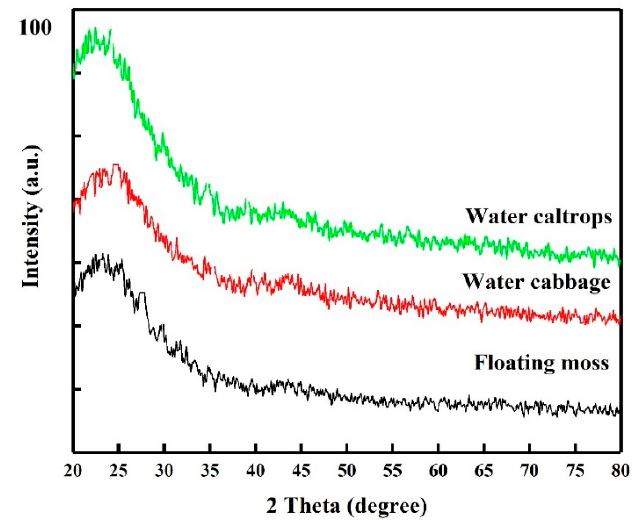
Figure 1. X-ray diffraction patterns of the silicon oxycarbide (SiOC) samples. Figure 1. X-ray di ff raction patterns of the silicon oxycarbide (SiOC)